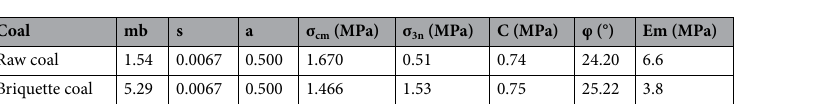
Table 3. Mechanical parameters of coal